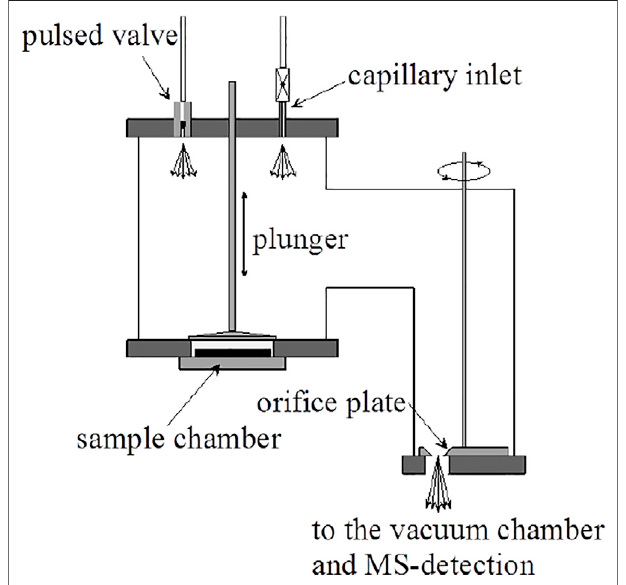
FIGURE 2 | Essential Construction Elements of the two-chamber Knudsen fl ow reactor (KFR) suitable for multiphase reactions and molecular beam-modulated quadrupole mass spectrometric detection (MBMS).